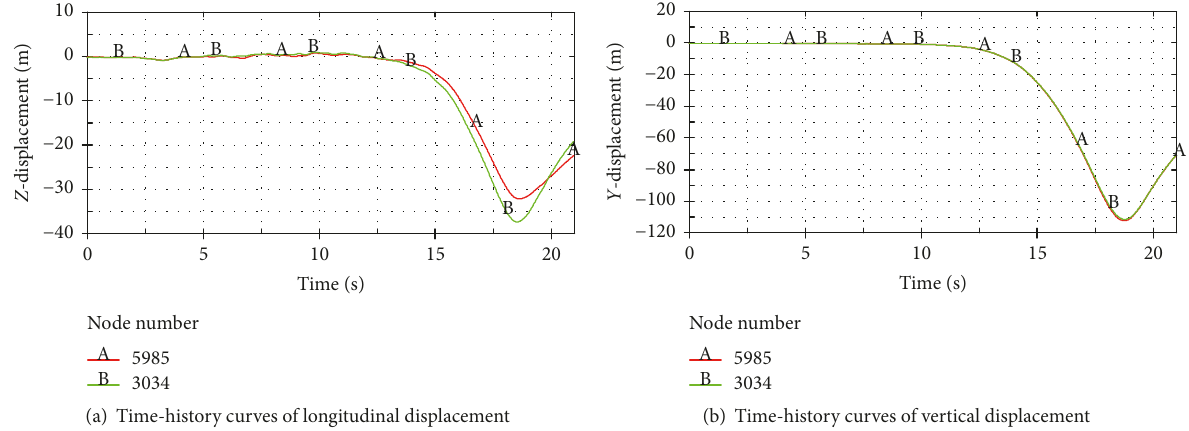
Figure 17: The displacement time-history curves of A and B nodes of girder